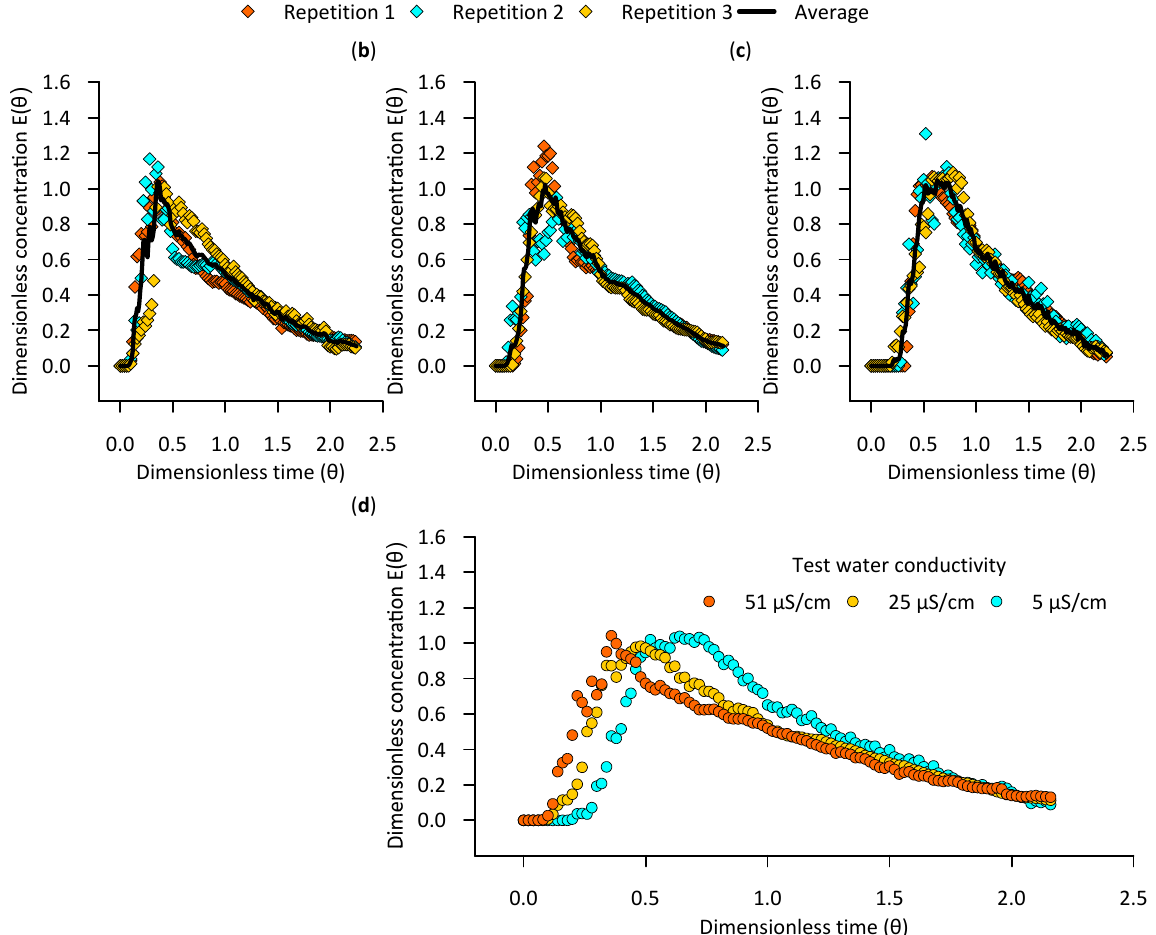
Figure 7. Effect of test water conductivity on RTD characterization: ( a ) 51 μS/cm test water, ( b ) 25 μS/cm test water, ( c ) 5 μS/cm test water, ( d ) Comparison of averaged results.